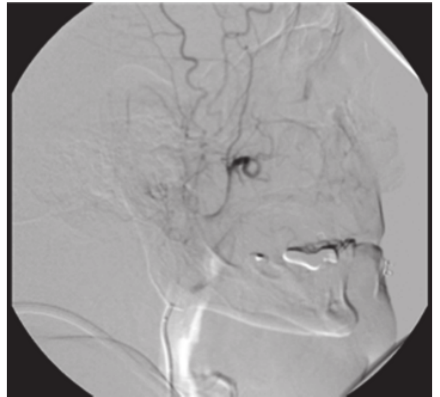
Figure 1: Left internal maxillary artery embolization. Figure 2: Persistent nosebleeds after embolization.